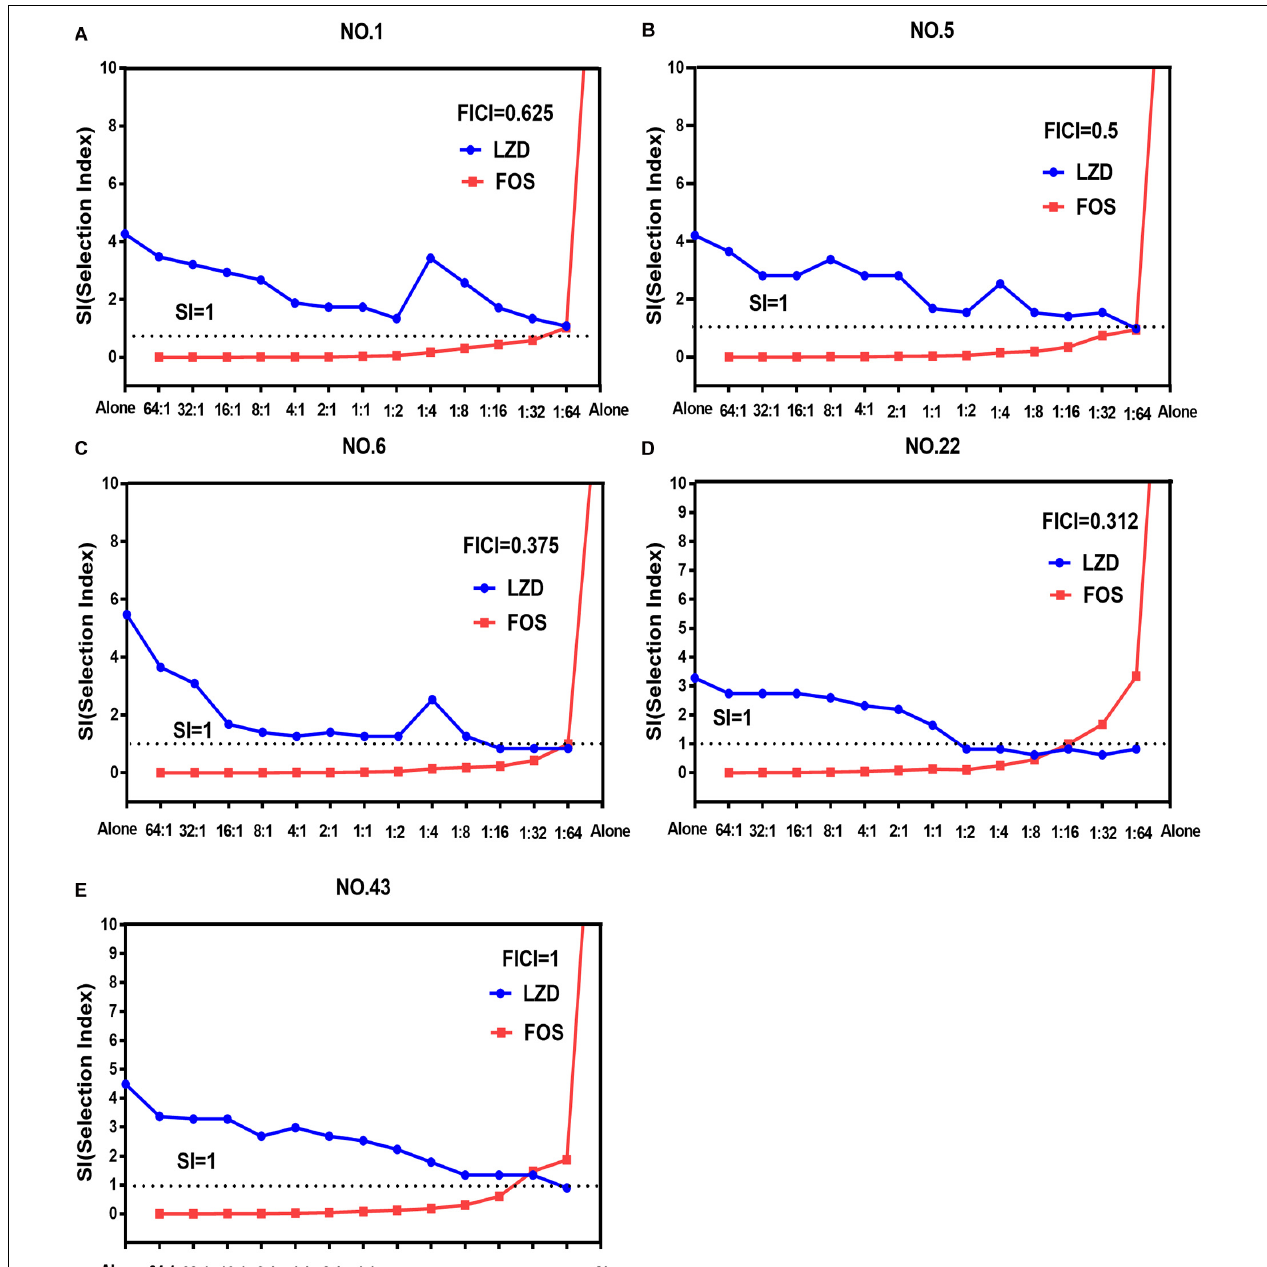
FIGURE 1 | Mutant selection indexes (SIs) of linezolid and fosfomycin when the two agents used alone or in combination with different ratios (linezolid: fosfomycin) against five enterococci. (A) NO.1 strain; (B) NO.5 strain; (C) NO.6 strain; (D) NO.22 strain; (E) NO.43 strain; LZD, linezolid; FOS, fosfomycin; FICI, fractional inhibitory concentration index; that the SIs of two agents in a combination including thirteen proportions were simultaneously less than or equal to one represented their MSWs were closed each other.